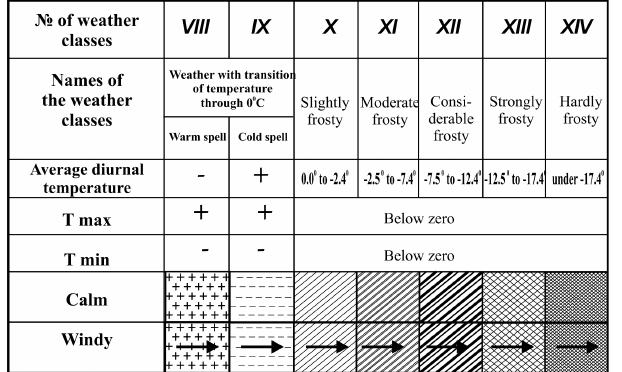
Figure 2. Weather classes during the cold part of the year (source: Tishkov,